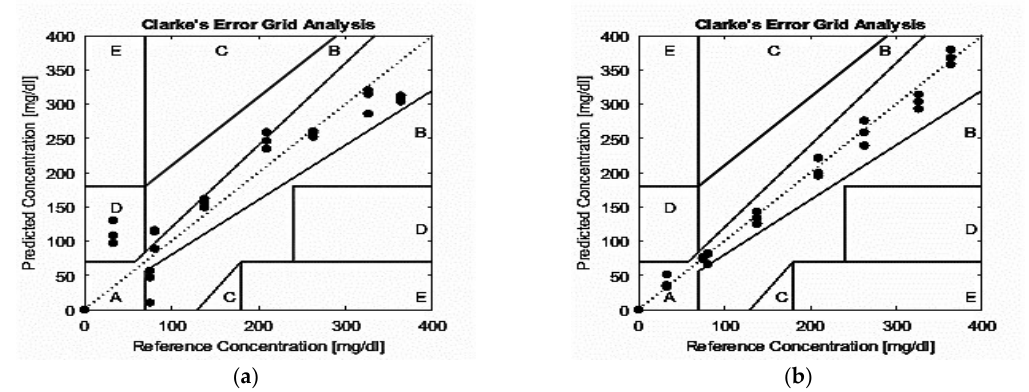
Figure 3. Clarke’s error grid for the predicted concentration and reference concentration with ( a ) raw spectra ( b ) baseline corrected + Chebyshev filtered spectra analyzed through PLS.